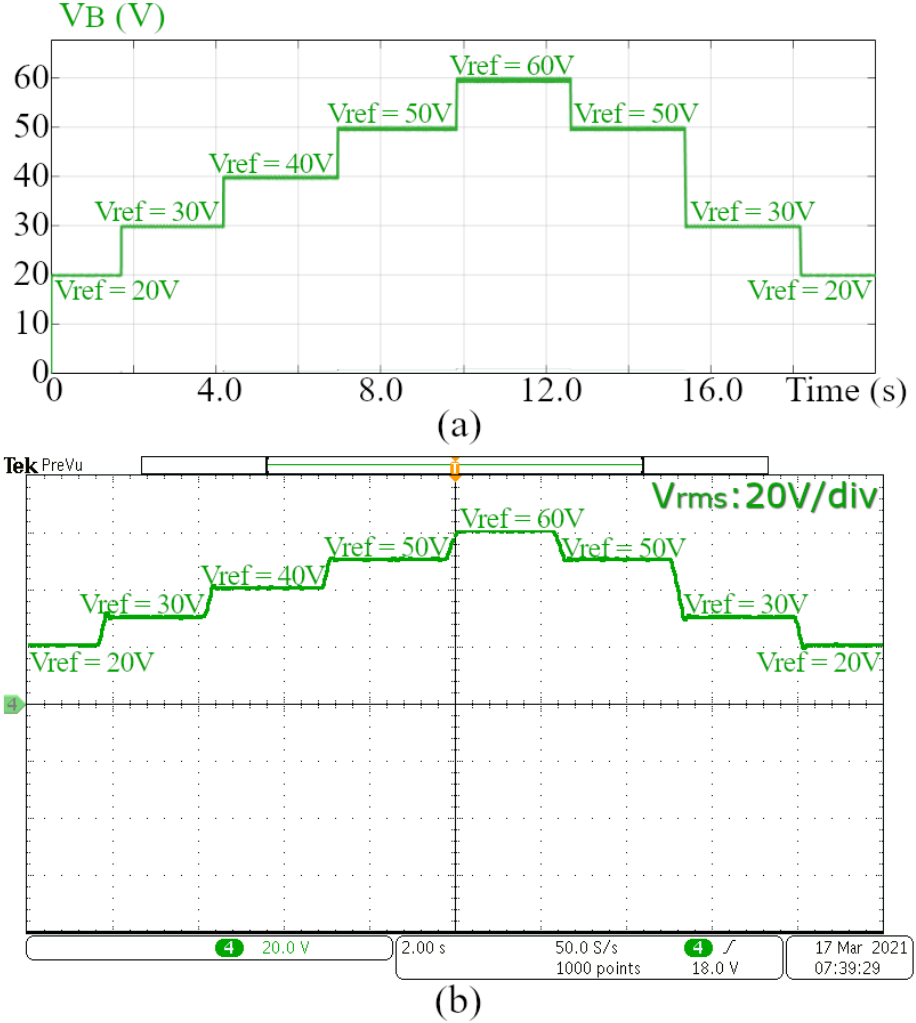
Figure 11. V B at varying irradiance levels from ( a ) simulation and ( b ) experiment.